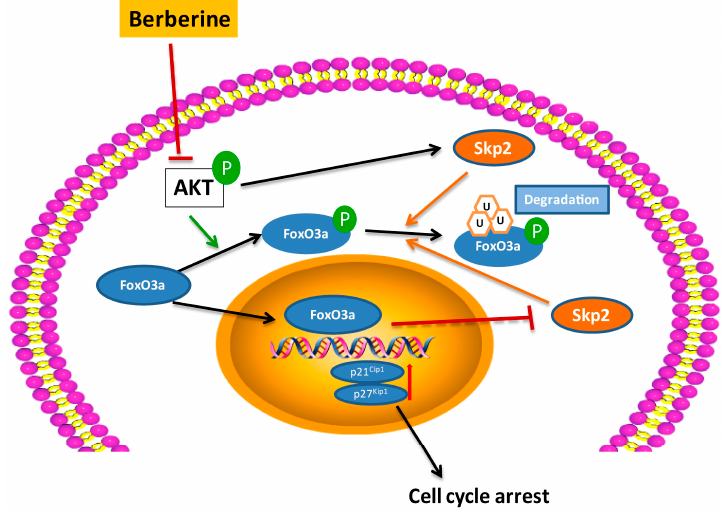
Figure 6. Schematic model of the mechanism underlying the effect of berberine on cell cycle arrest. P: phosphorylation; u: ubiquitylation.